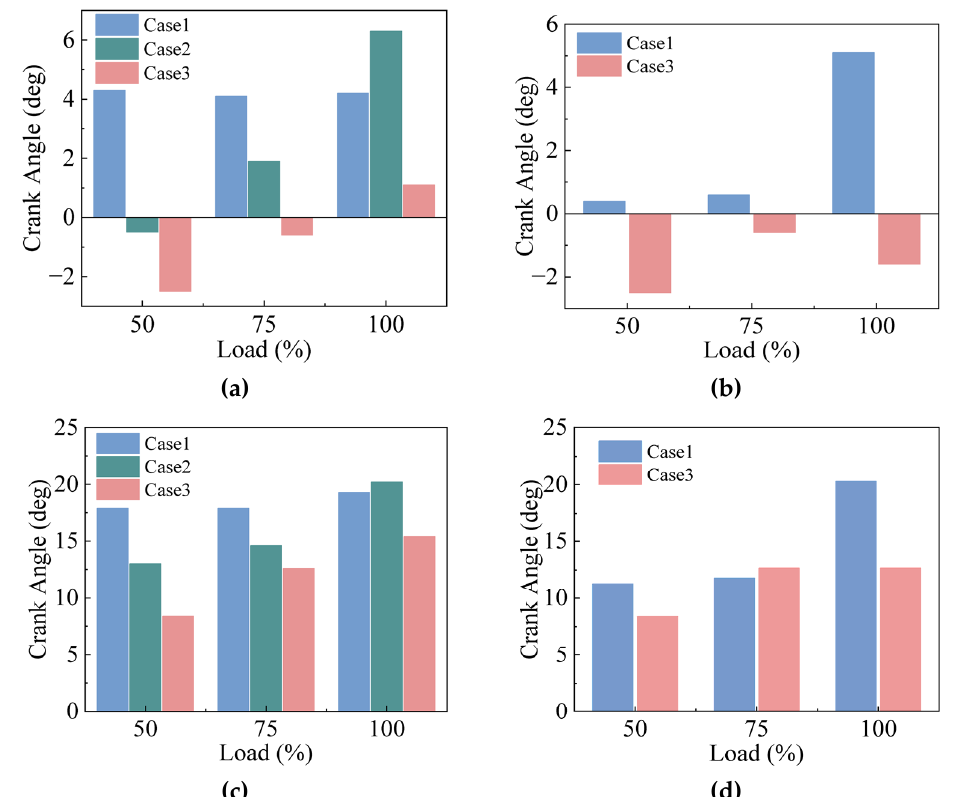
Figure 5. CA5/CA50 for variable EBP at different loads. ( a ) EBP = 10 kPa, CA5; ( b ) EBP = 25 kPa, CA5; ( c ) EBP = 10 kPa, CA50; ( d ) EBP = 25 kPa, CA50.